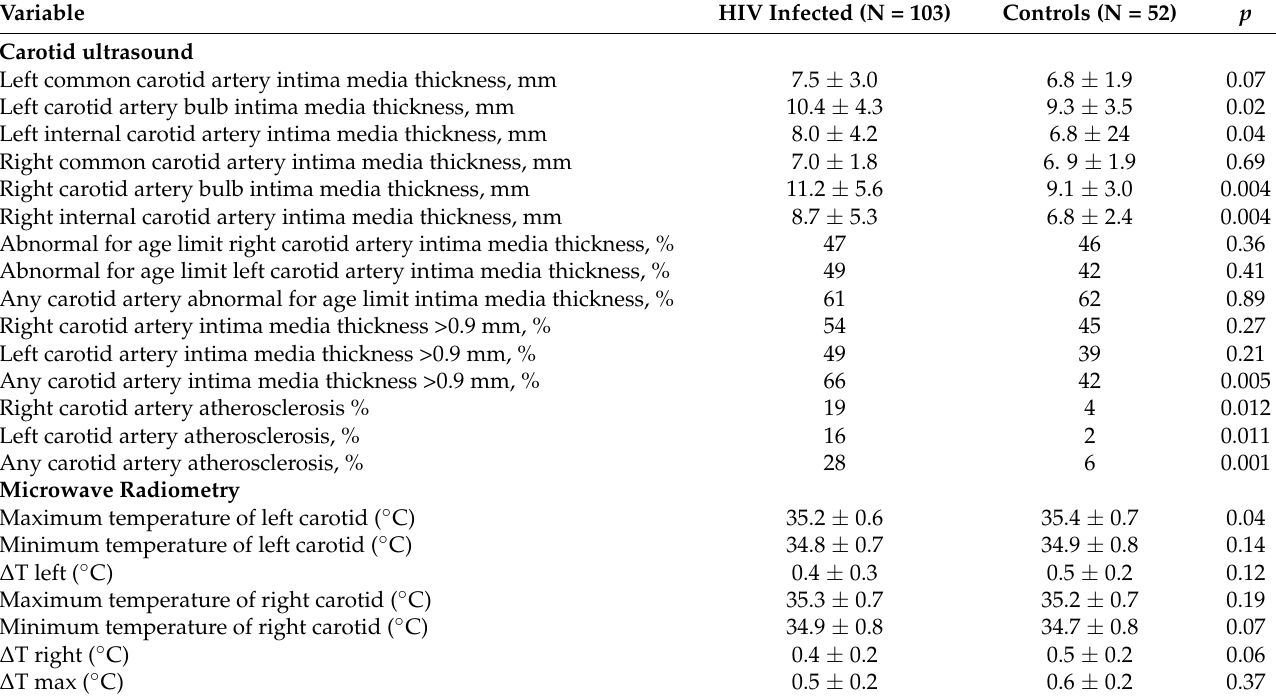
Table 2. Baseline assessment of vascular markers in PLWH and